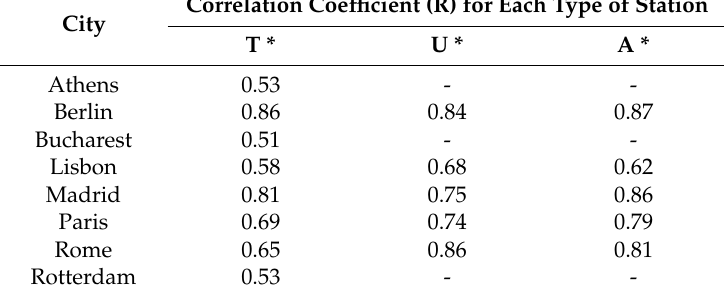
Table 3. Correlation coefficients between OMI and ground-based in-situ measurements using the seasonal variation of NO 2 . Correlation Coefficient (R) for Each Type of Station City T * U * A * Athens 0.53 - - 0.86 0.87